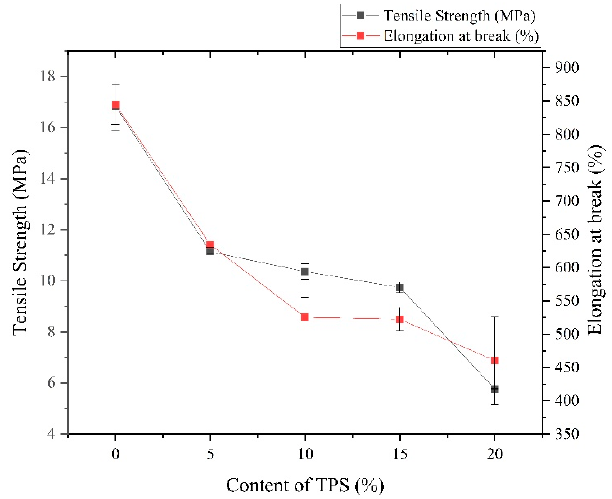
Figure 9. E ff ect of TPS content on the mechanical properties of composite films. Figure 9. Effect of TPS content on the mechanical properties of composite films.